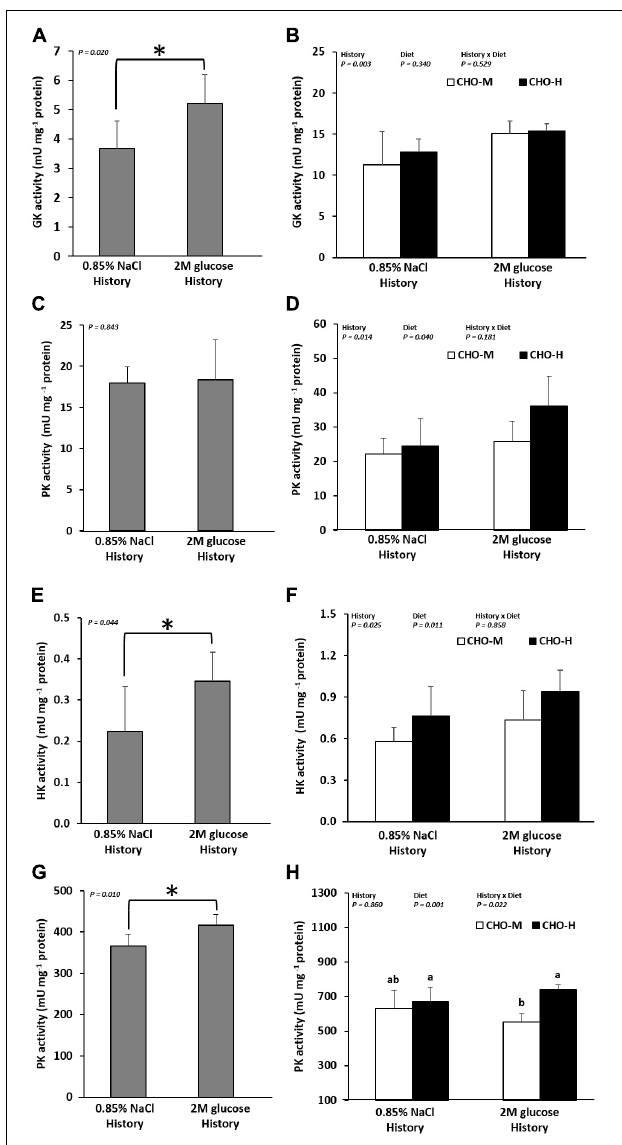
FIGURE 4 | Enzyme activity (mU mg − 1 protein) in the livers and muscles of Nile tilapia that were microinjected with either 0.85% NaCl or 2 M glucose (history). GK (A,B) and PK (C,D) , which are involved in glycolysis, were analyzed in the liver samples. HK (E,F) and PK (G,H) , which are involved in glycolysis, were analyzed in the muscle tissue samples. At 21–24 wpi, the fish were subjected to a challenge test with different dietary carbohydrate levels (37% carbohydrates, CHO-M; 67% carbohydrates, CHO-H). Before the challenge test, the fish were sampled to determine the effect of the glucose injection history on the GK and PK activity in the liver (A,C) and the HK and PK activity in the muscles (E,G) . The asterisk in the bar graph indicates a significant difference ( P < 0.05). After the challenge test (24 wpi), the combination effects of glucose history and challenging diet on the GK and PK activity in the liver (B,D) and the HK and PK activity in the muscles (F,H) were examined. Data are presented as the mean ± standard deviation (SD) ( n = 6). Two-way ANOVA was used to analyze the effects of glucose injection (History), challenging diet (Diet) and their interaction (History × Diet). When significant interaction effects were observed, one-way ANOVA following Tukey’s range test was performed to rank the treatment combination groups. Different letters in the bar graph indicate significant differences ( P <